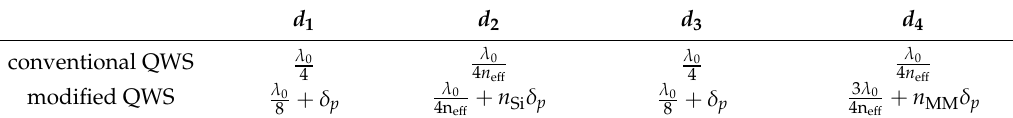
Table 1. Layer thicknesses d 1 -d 4 for the conventional and modified quarter wave stack, respectively.